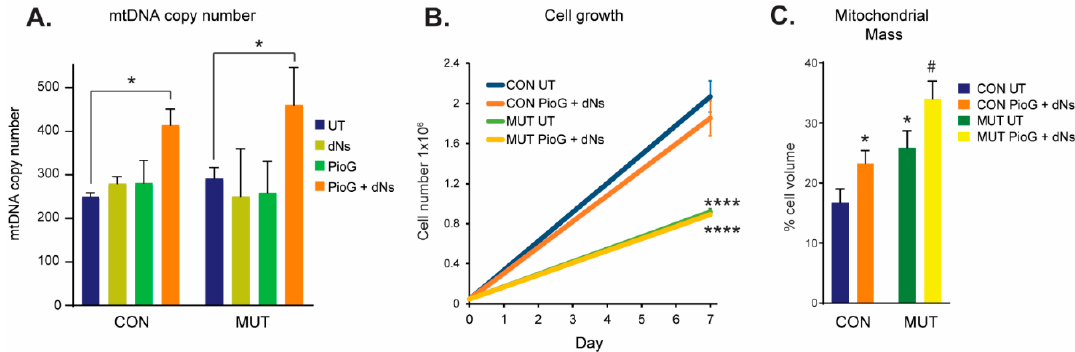
Figure 1. Effect of seven days of PioG + dNs combination treatment in control (CON) cybrids